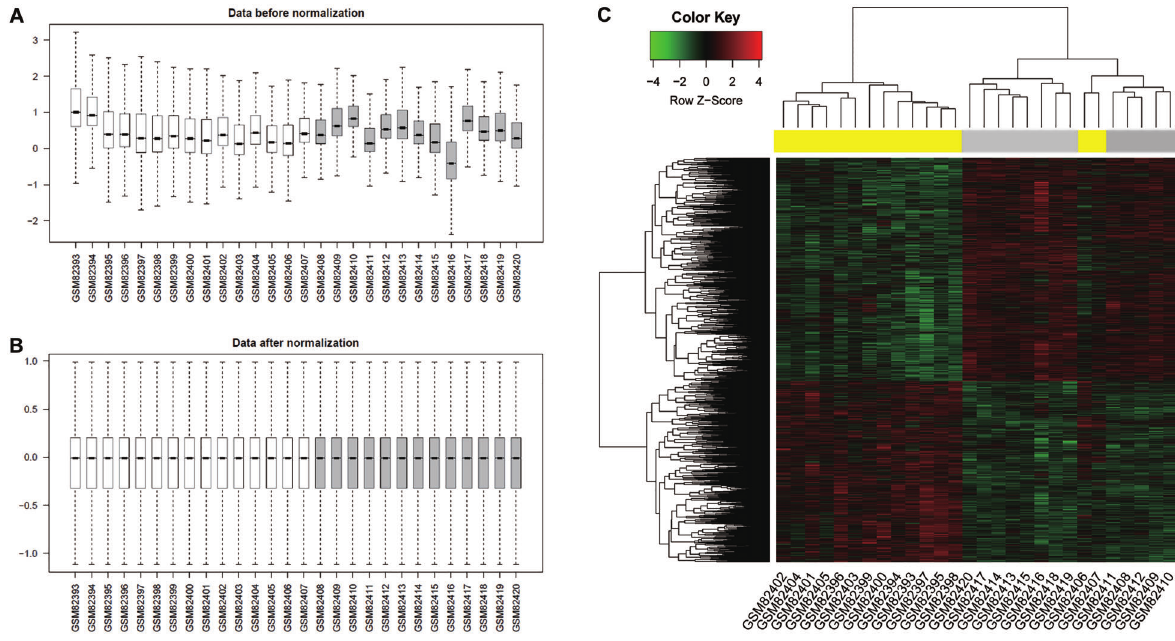
Figure 1. Normalization of gene expression data and hierarchical clustering of differentially expressed genes (DEGs). A , gene expression pro fi les before normalization. White boxes represent normal samples, while gray boxes stand for dilated cardiomyopathy samples. B , gene expression pro fi les after normalization. C , hierarchical clustering of DEGs. Yellow boxes represent normal samples, while gray boxes stand for dilated cardiomyopathy samples. The green and red bars represent low and high expression levels, respectively. GSMxxxxx: the accession number of a certain sample in the Gene Expression Omnibus